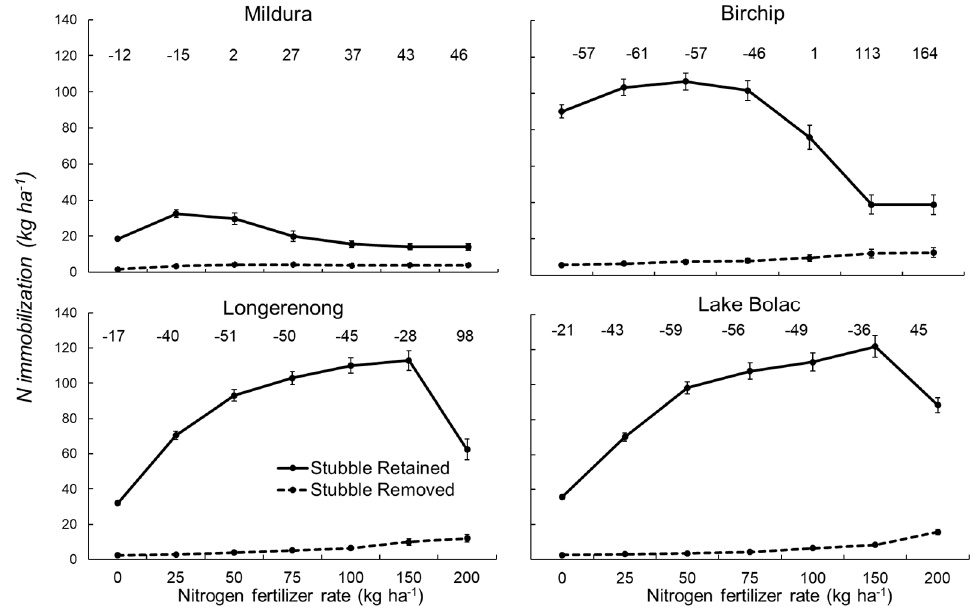
Figure 4. Effects of N application rate and stubble retention (retained vs. removed) on the mean (1990–2016) annual N immobilization at four field sites to 130 cm depth. Error bars represent ± standard error of the mean over the years of the simulation. Numbers at the top of the graphs are the N balance (fertilizer input minus offtake in grain, leaching and denitrification) in kg ha − 1 of the retained treatment.